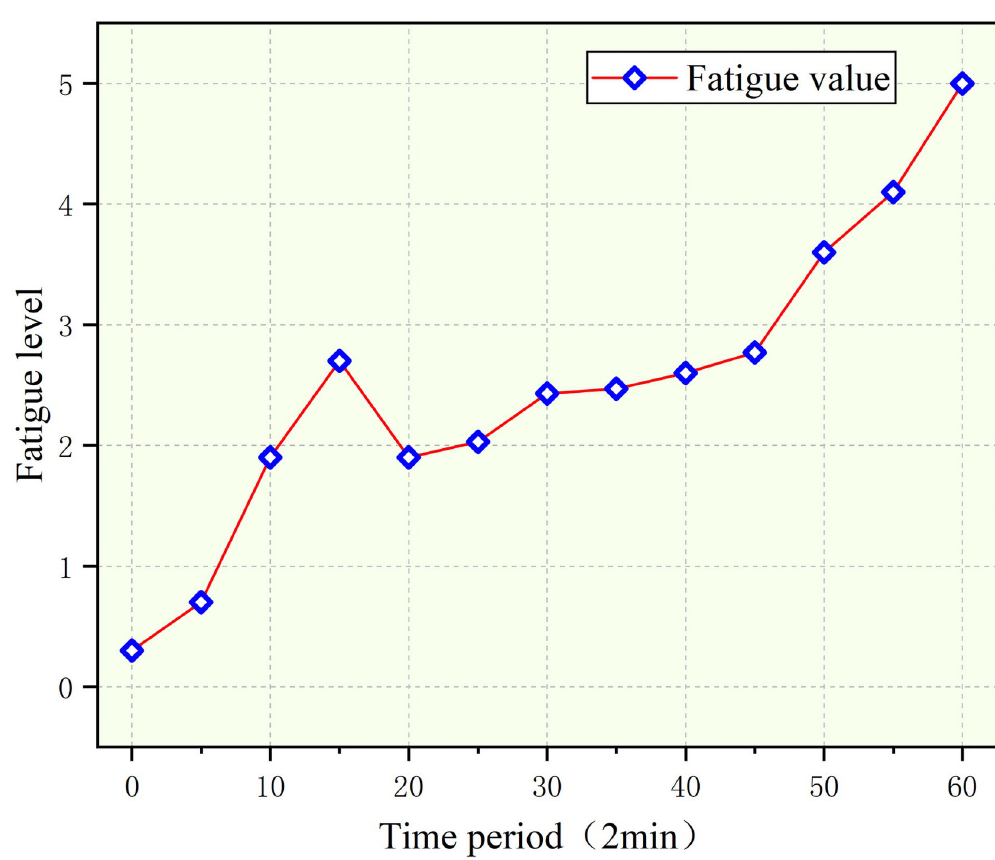
Fig 17. Trend for subjective comfort under